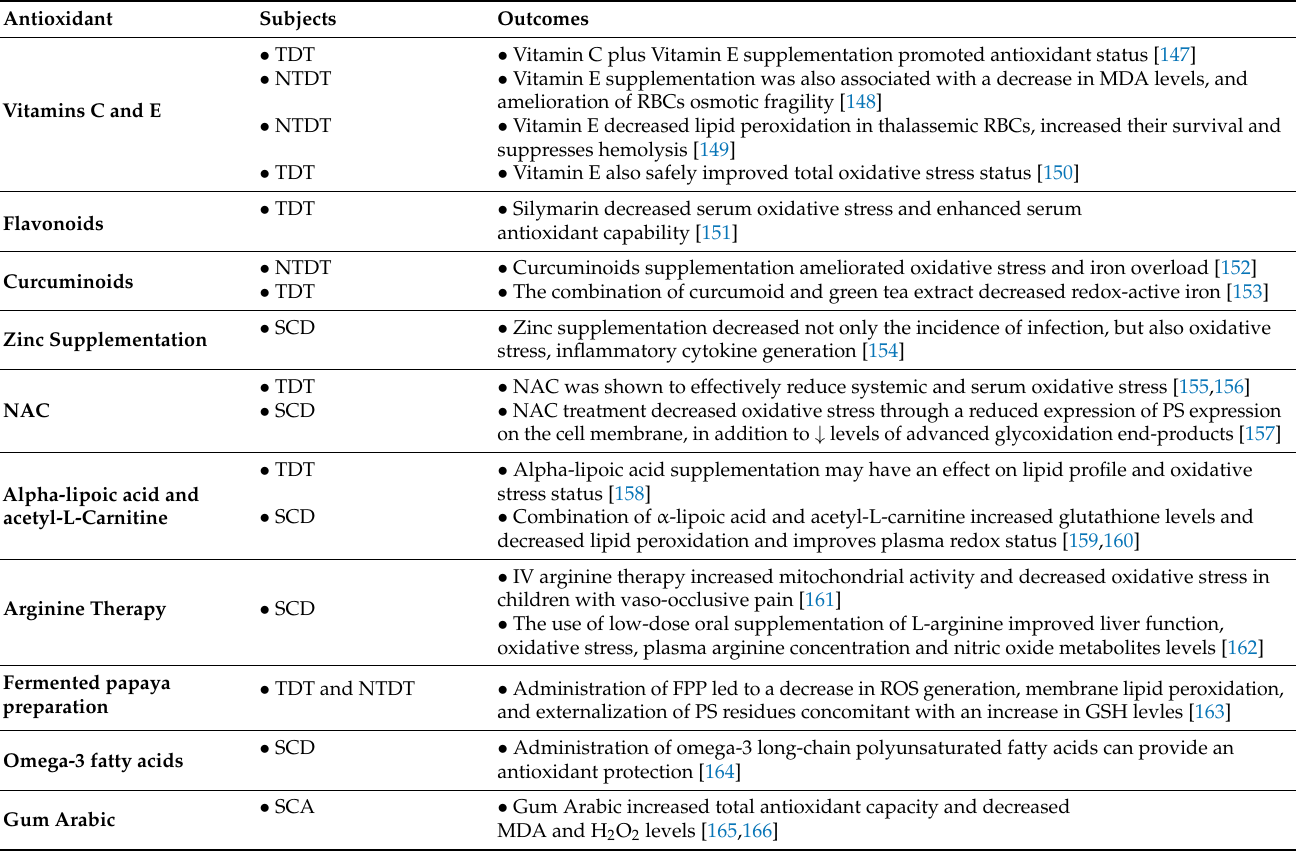
Table 1. Antioxidant therapies in β -thalassemia and SCD